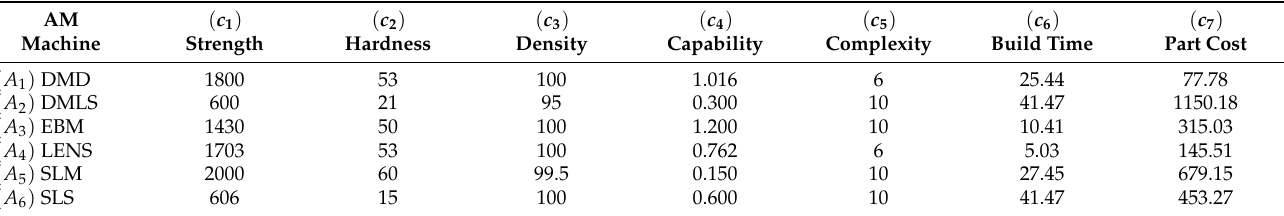
Table 6. Example 1 σ = ( 0.35, 0.4, 0.4, 0.4, 0.5, 0.35, 0.4 ) .